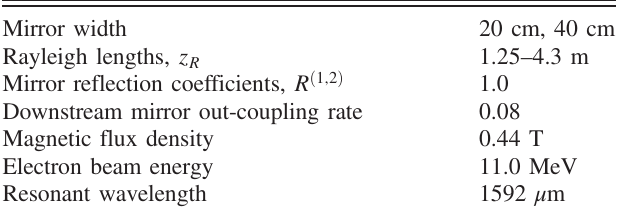
TABLE III. Parameters of simulation.